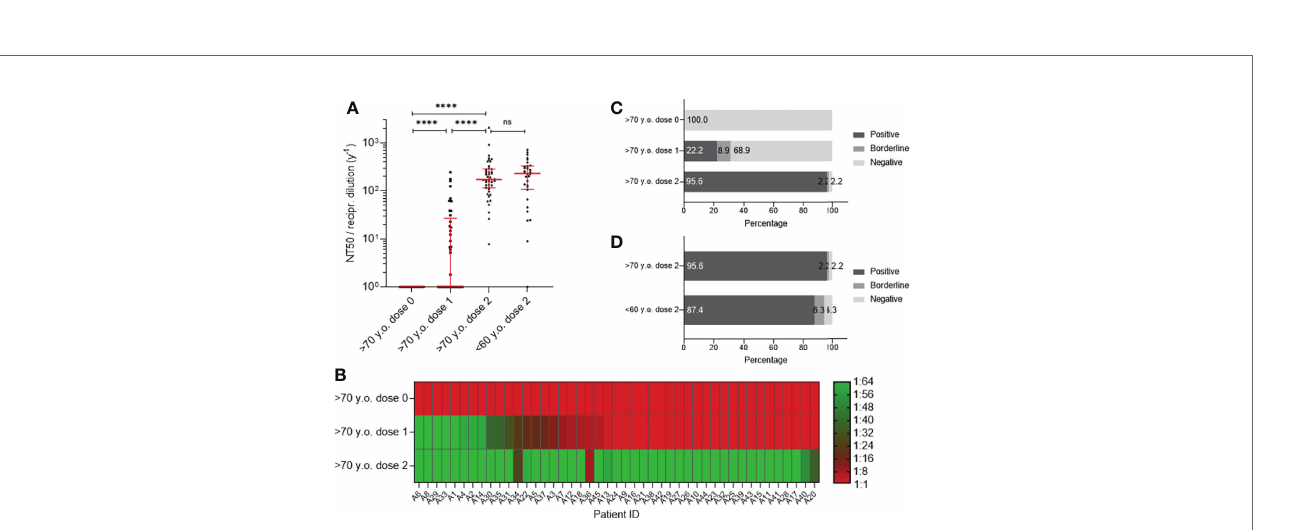
FIGURE 4 | Analysis of neutralization titer (NT50) against SARS-CoV-2 Delta variant using sera from participants older than 70 years (n = 45) before vaccination (dose 0), after fi rst- (dose 1) and after second vaccination (dose 2) with BNT162b2 in contrast to fully vaccinated participants younger than 60 years (n = 32). Neutralization titers are presented as a dilution factor for serum (1:x). (A) Individual NT50 values are shown as individual progressions for each person until full immunization with BNT162b2. In contrast, individual titers for 50% neutralization are illustrated for people younger than 60 years of age fully vaccinated with BNT162b2. Medians are visualized together with the interquartile range as an error bar. Statistical signi fi cance between values at the three different time points for the group >70 y.o. was determined using the Wilcoxon test. A Mann – Whitney – U test for nonparametric distribution was applied for comparison of immune responses between the two age groups. [p > 0.05 not signi fi cant (ns), and p ≤ 0.0001 (****)].. (B) Heat map for visualization of NT50 progression against the SARS-CoV-2 WT before and after vaccination with BNT162b2. Illustrated colors shift from red for a negative- to green for a positive antibody status. (C) Percentages of participants with positive, borderline or negative for half- maximum neutralization against SARS-CoV-2 Delta variant are shown for time points before-, after the fi rst and second vaccination. (D) Comparison of percentages of persons older than 70 years and people younger than 60 years with positive, borderline or negative half-maximum neutralization of SARS-CoV-2 Delta